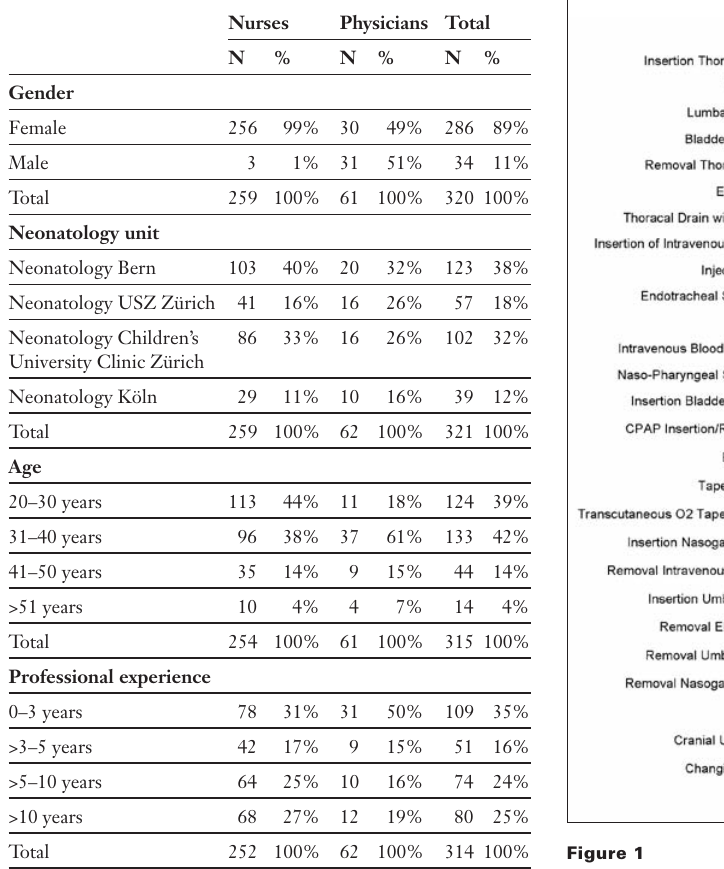
Ranking by median of procedures’ pain intensity. (Values: boxes are inter-quartile ranges, the midpoints are medians and whiskers are ranges without